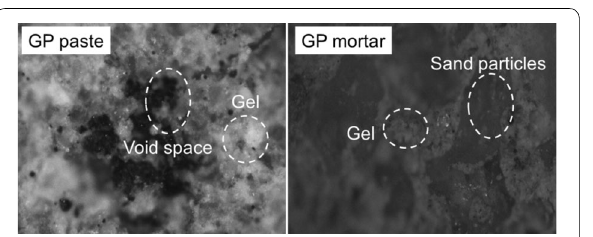
Fig. 9 Microscopic images of S60 geopolymer.